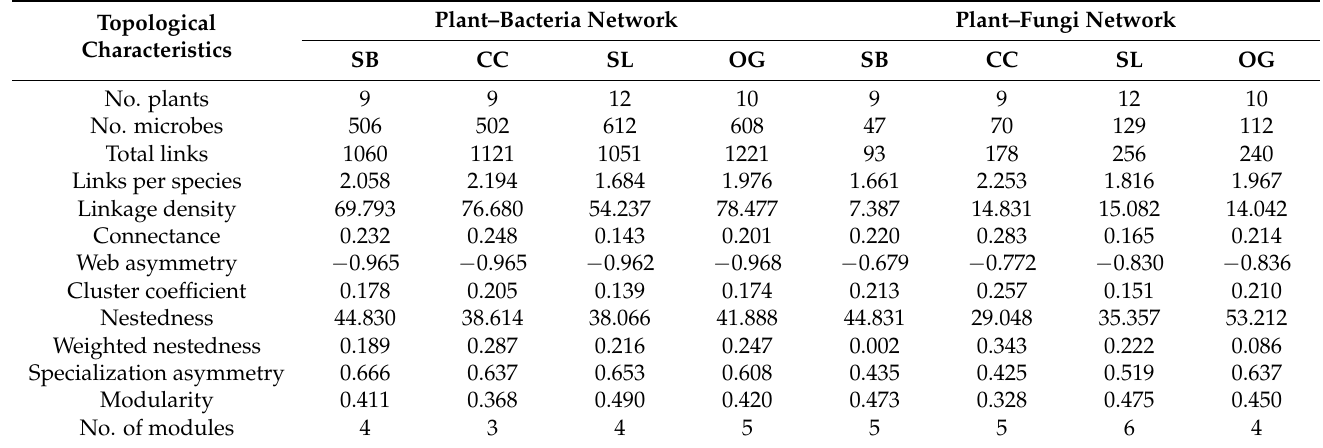
Table 2. IDEN topological characteristics for plant–microbe ecological